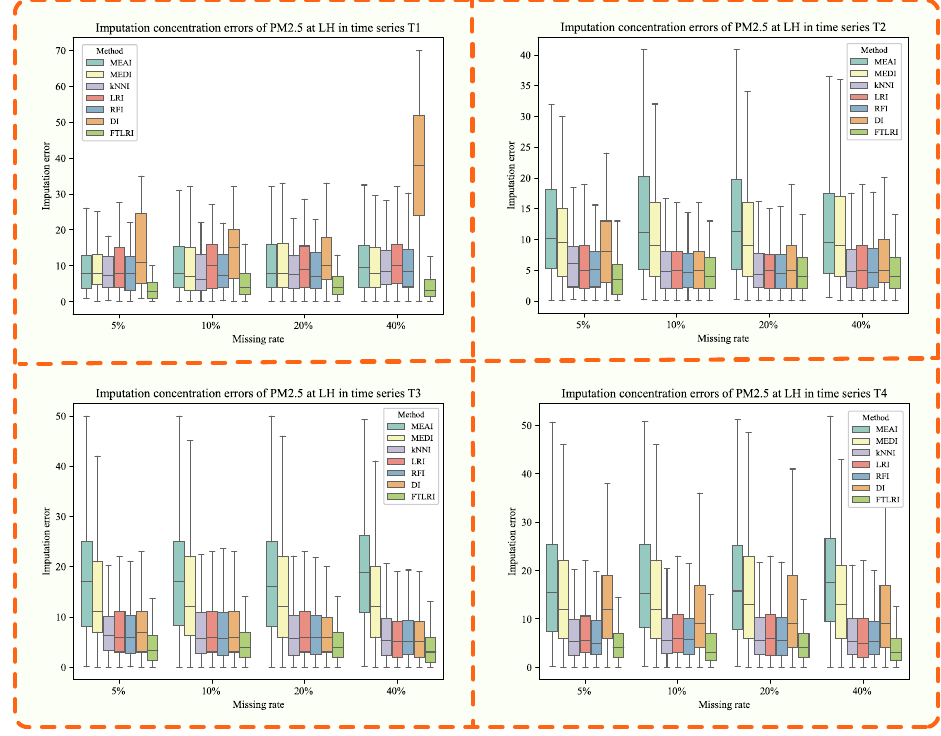
Figure 7. Imputation concentration errors of PM 2.5 generated by MEAI, MEDI, kNNI, LRI, RFI, DI, FTLRI at LH in different time series.